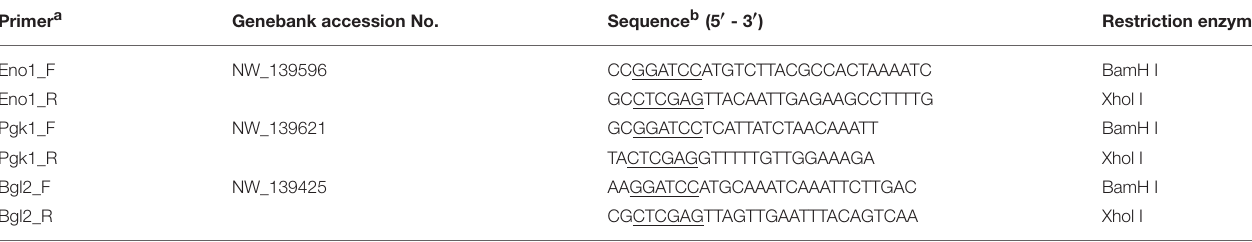
TABLE 2 | Oligonucleotide primer sequences used in this study. Primer a Genebank accession